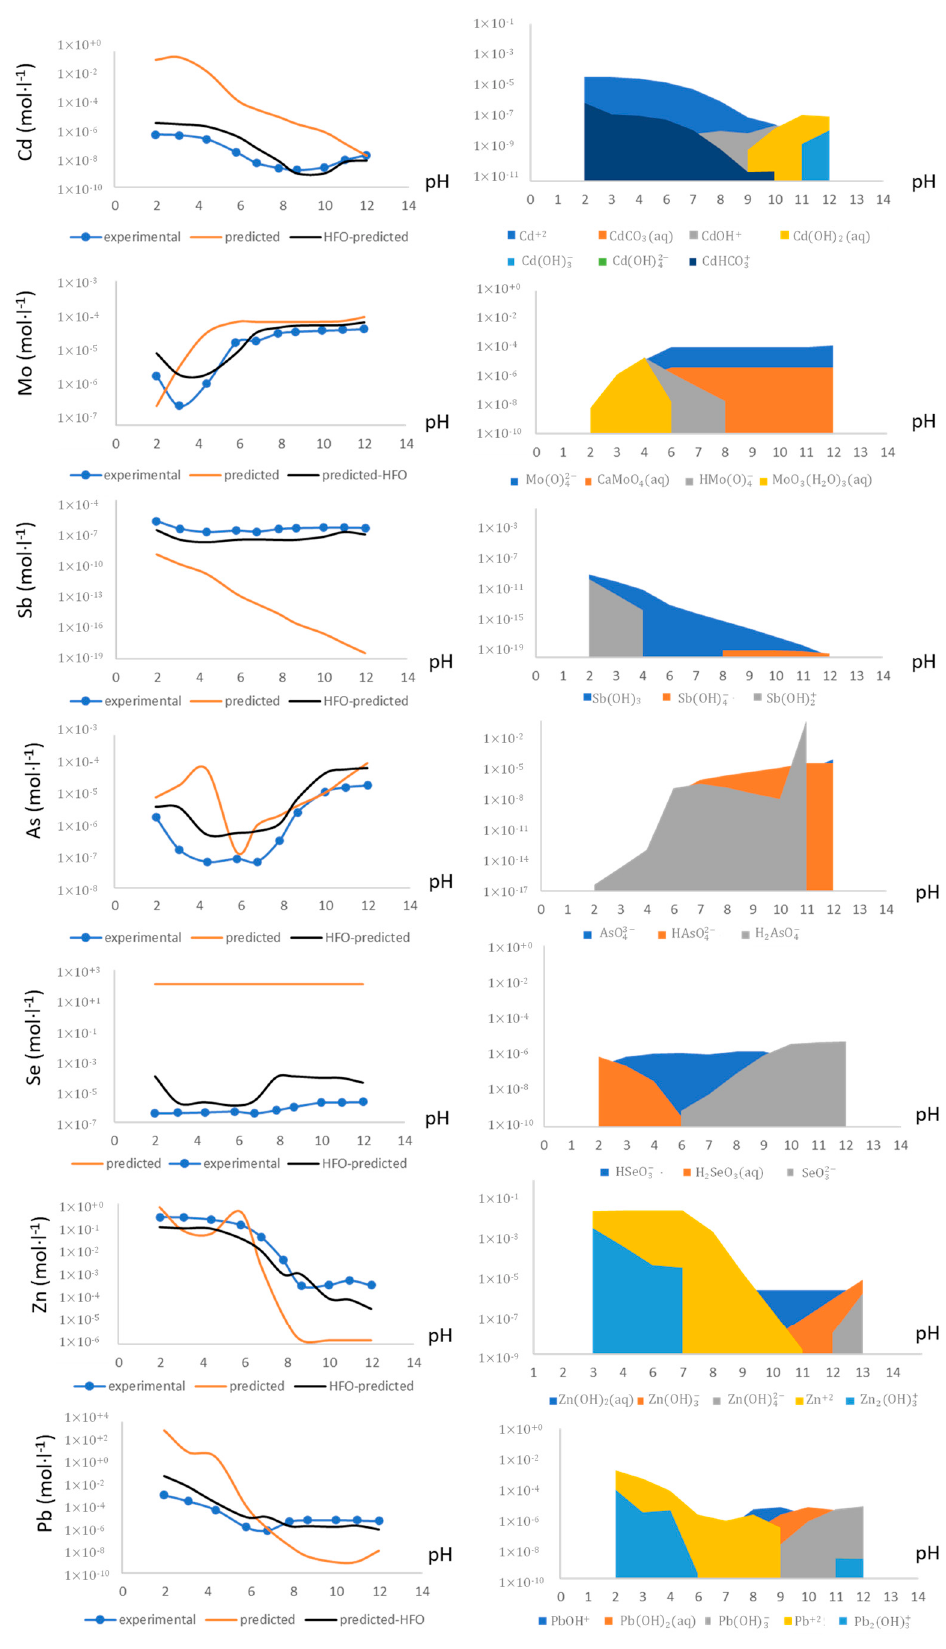
Figure 6. Measured and predicted leaching behavior of the selected trace elements as a function of pH (on the left); chemical speciation modeling of the selected trace elements.